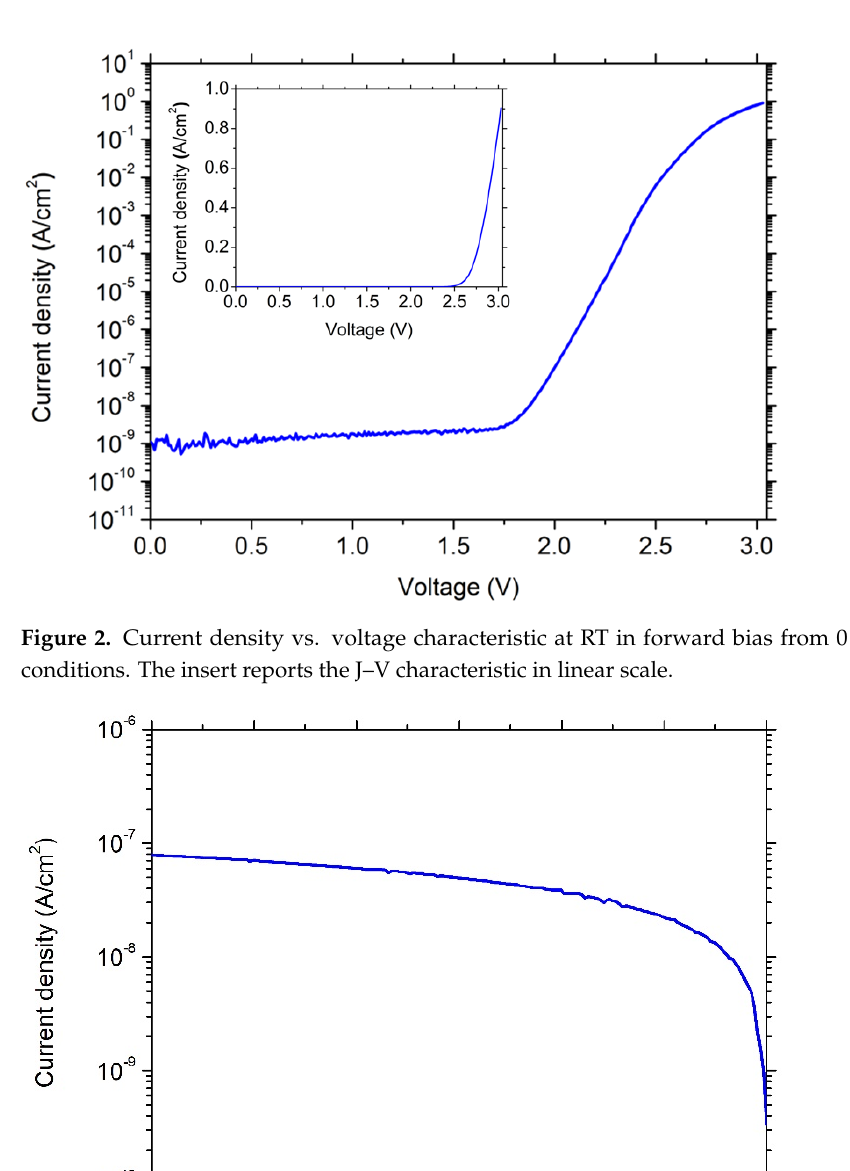
Figure 3. Current density–voltage characteristic, in dark conditions at RT, for reverse biases from 0 to − 30 V.